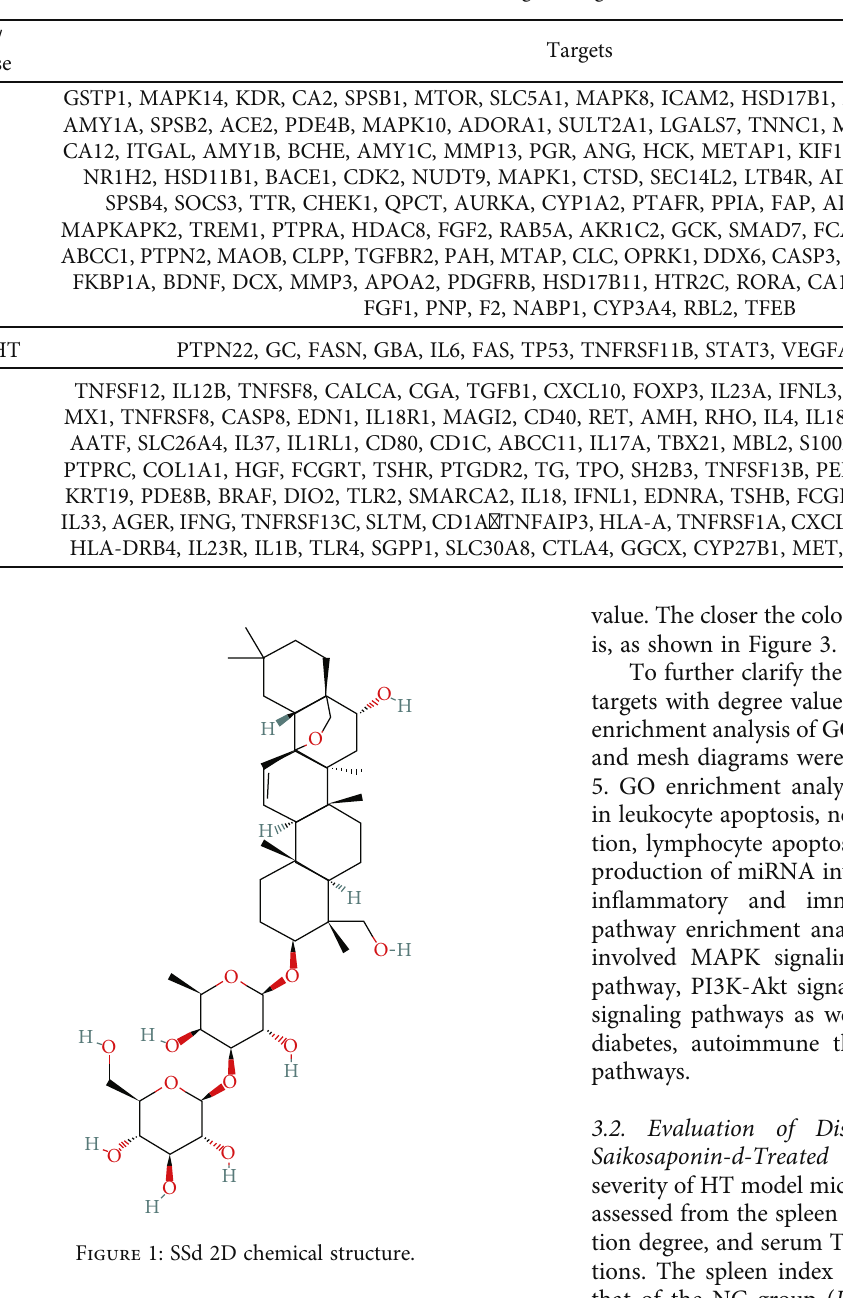
Table 2: Related gene targets of HT and SSd.